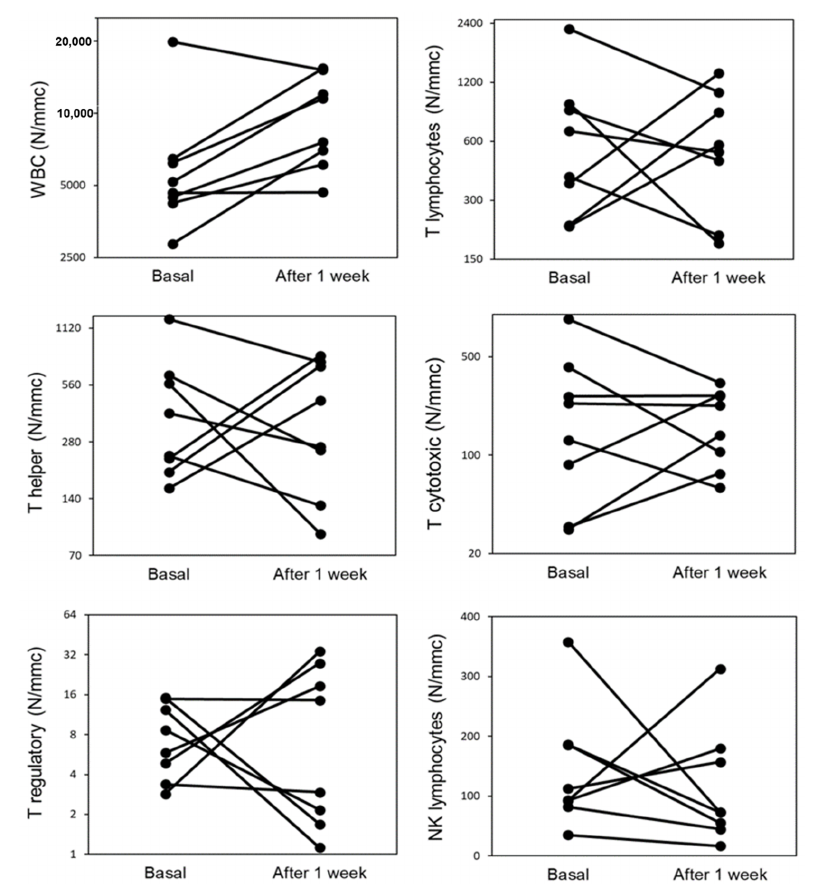
Figure 4. Circulating leukocytes (WBC), T and NK lymphocyte populations in COVID-19 patients that died during hospitalization ( n = 8), at hospital admission (basal) and after one week of hospi ‐